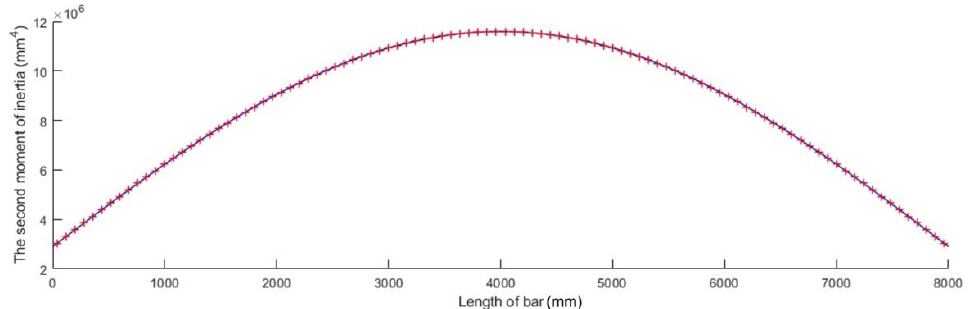
Figure 7. Sinusoidal variation in the second moment of inertia along the bar axis.